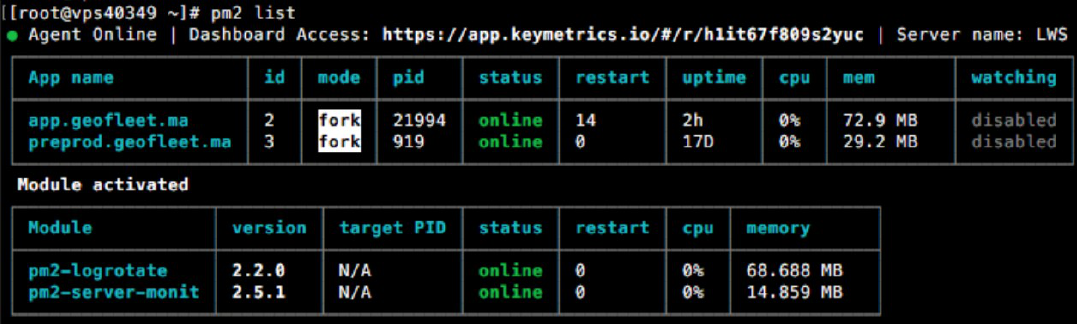
Figure 3. Server states of the